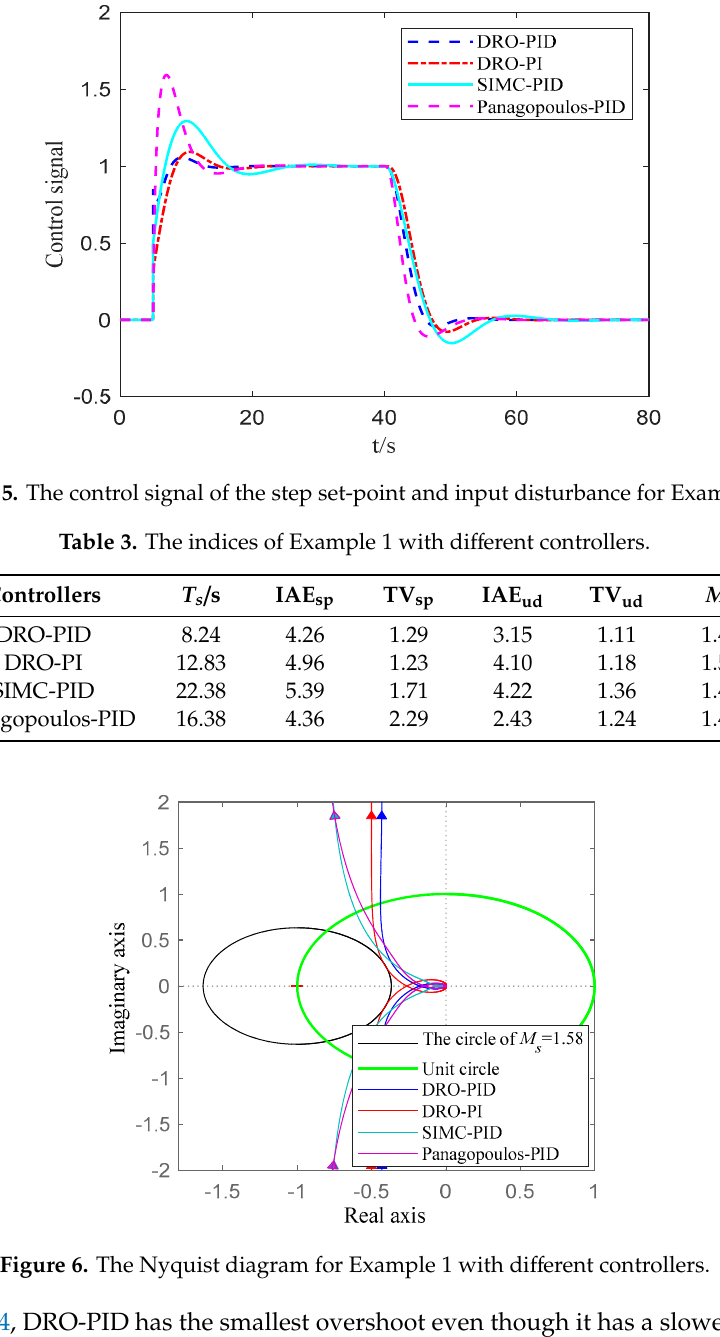
Figure 6. The Nyquist diagram for Example 1 with different controllers.